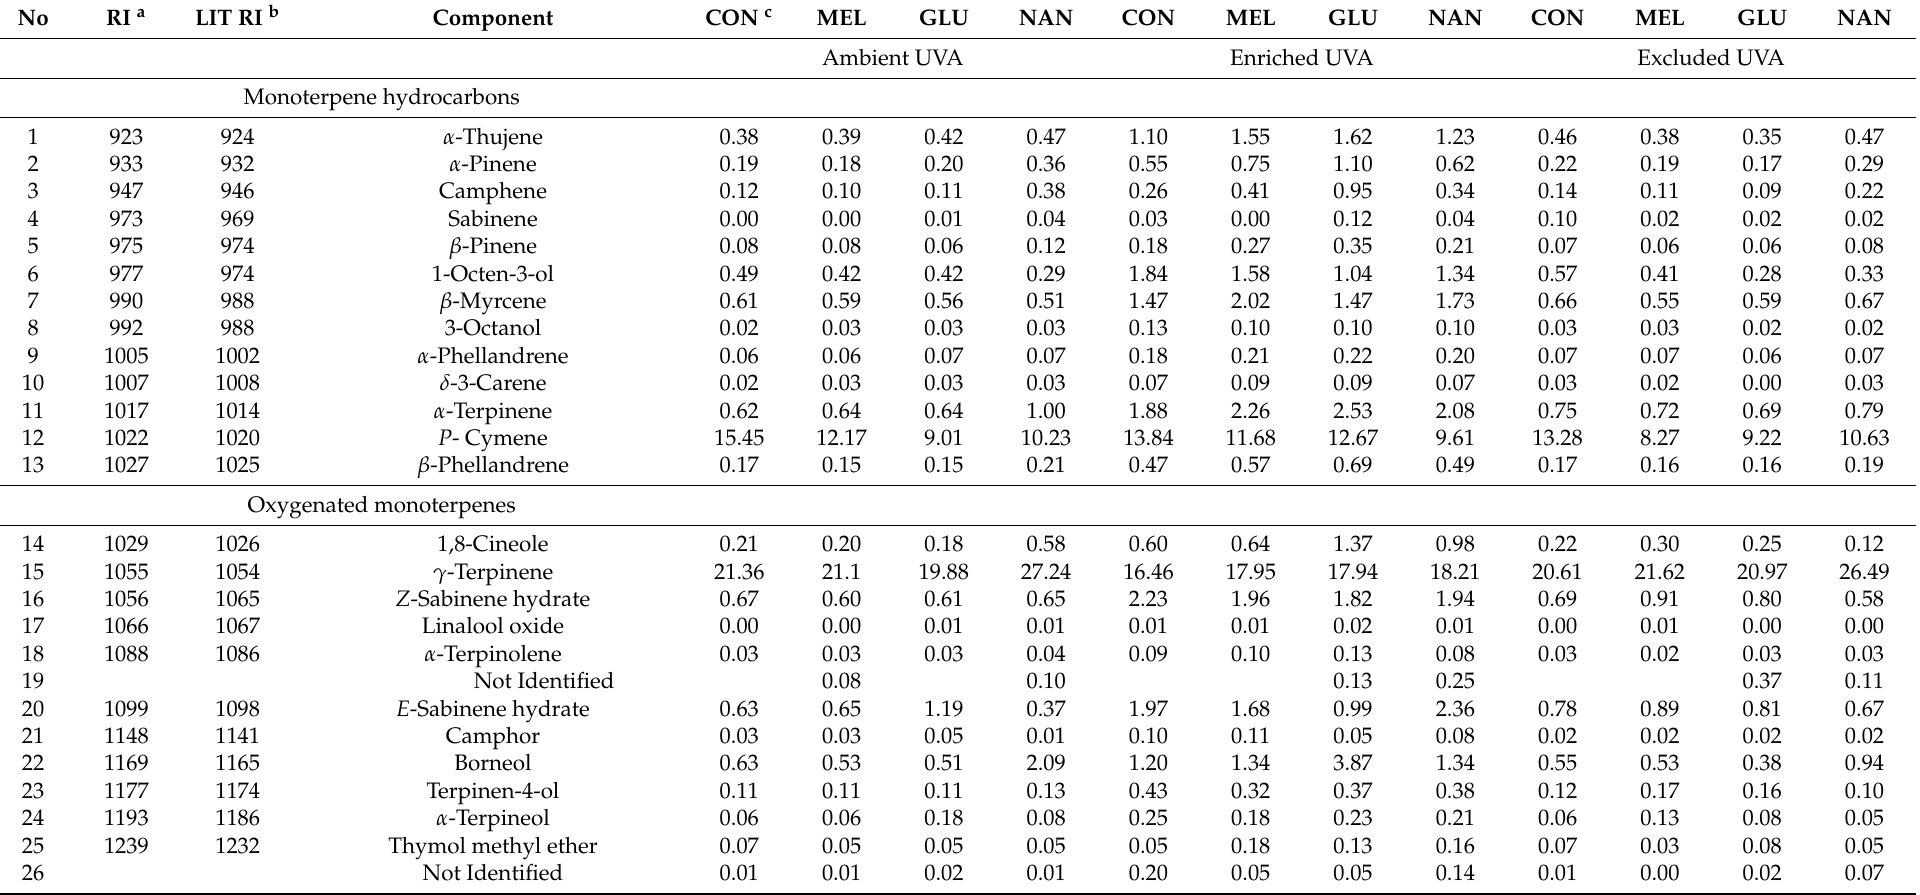
Table 6. The essential oil profile of Thymus vulgaris under different UVA levels (ambient, enriched, excluded) in combination with spraying protectants